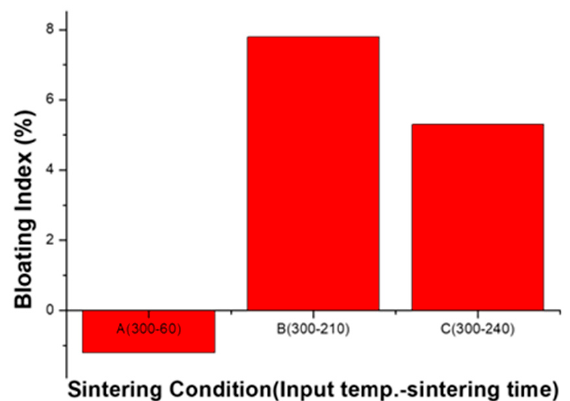
Figure 11. Bloating Index (BI) of the sintering aggregate.